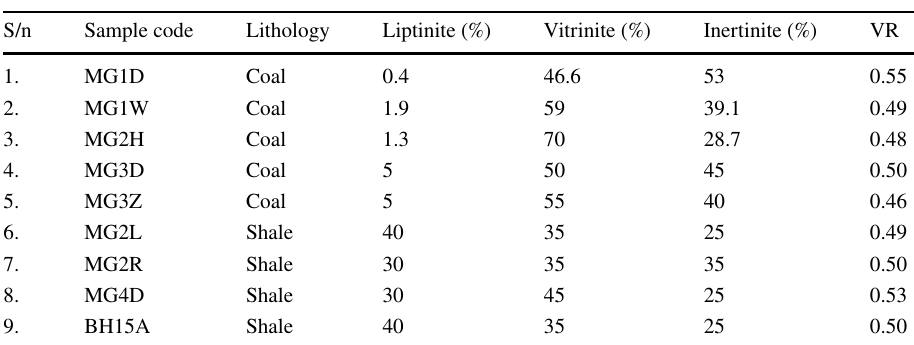
Table 5 Maceral and vitrinite reflectance of coal and shale samples of Maiganga Gombe Formation